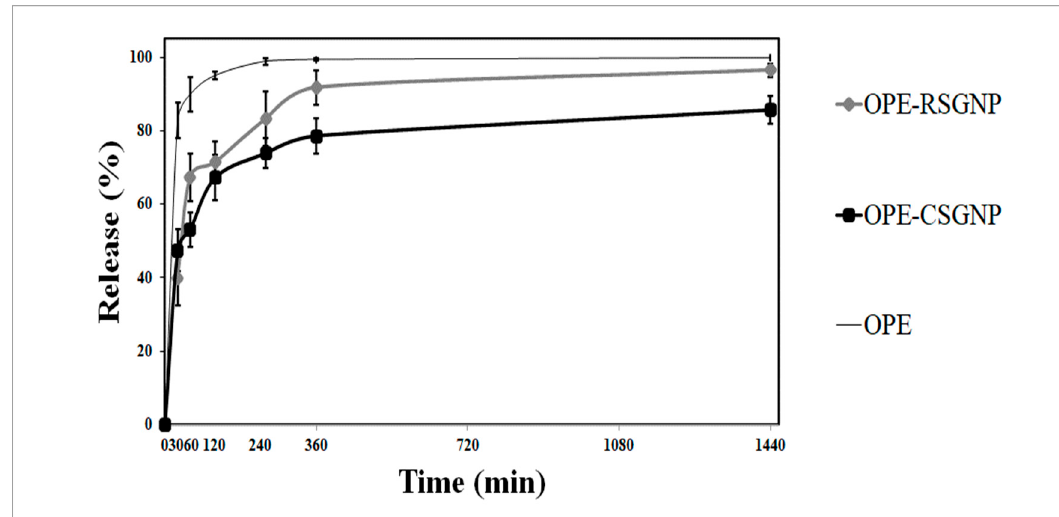
Figure 4. In vitro release profile of olive pomace extract (OPE) in solution and OPE-RSG, CSG NPs at small intestinal pH (7.4) for 24 h. Data are average ±standard express mean ( n = 3).